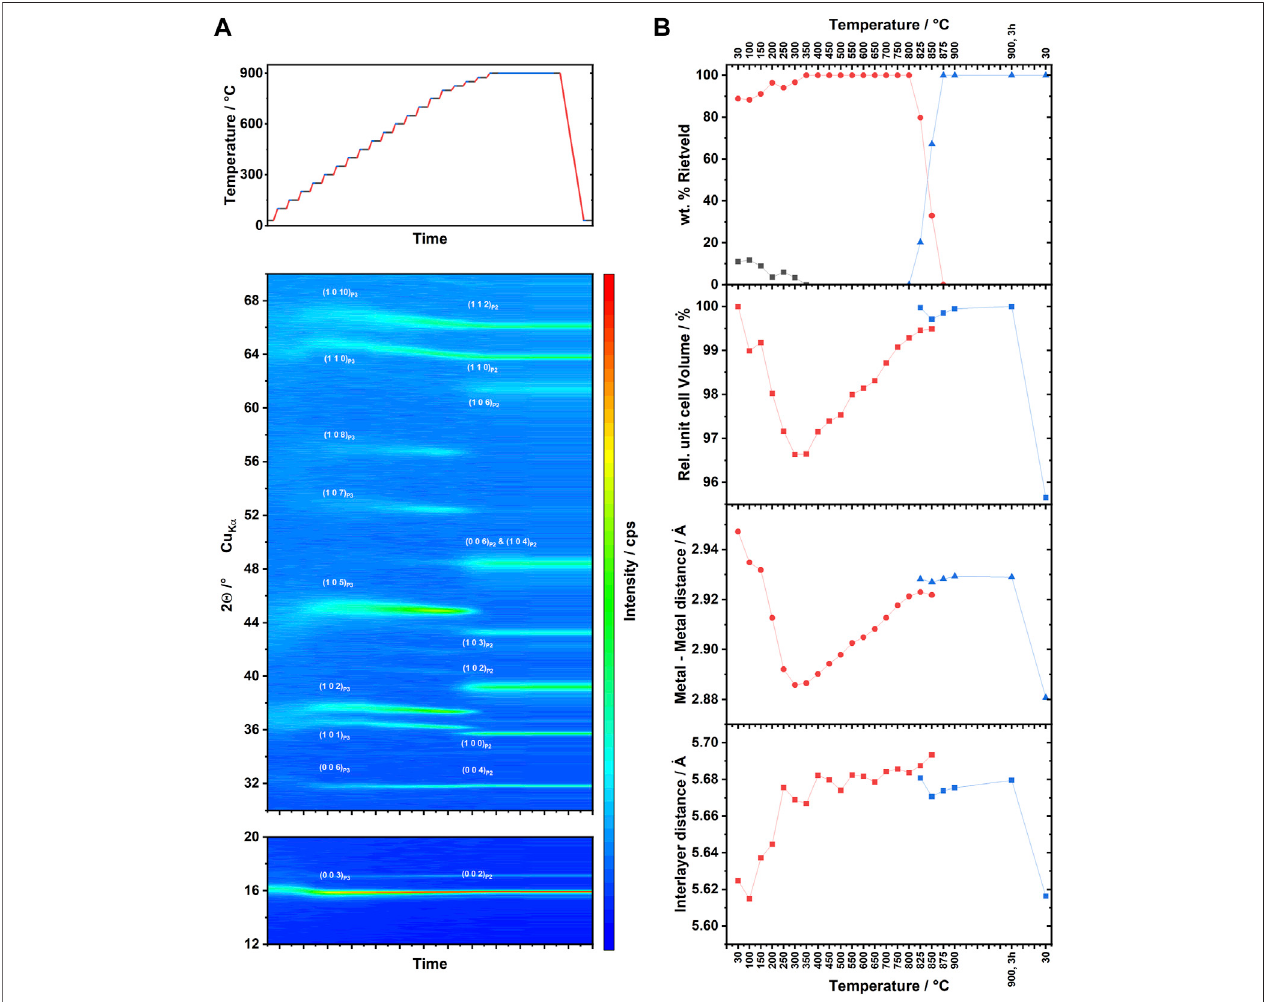
FIGURE 4 | In-situ XRD calcination of Na 2/3 Mn 3/4 Ni 1/4 O 2 in air. (A) The temperature pro fi le is represented in the upper diagram. The obtained diffraction pattern is represented as a heat map in the lower diagrams. (B) Re fi ned weight fractions, change of the unit cell volume, metal-metal distance ( a lattice parameter) and interlayer distance (proportional to c lattice